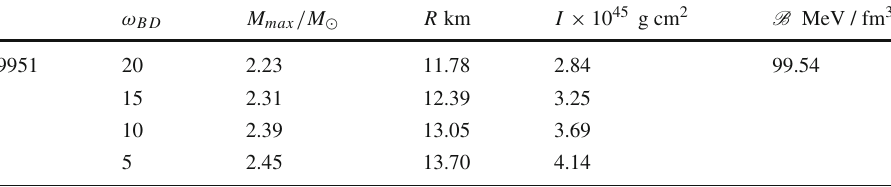
Table 4 Effects of α and ω